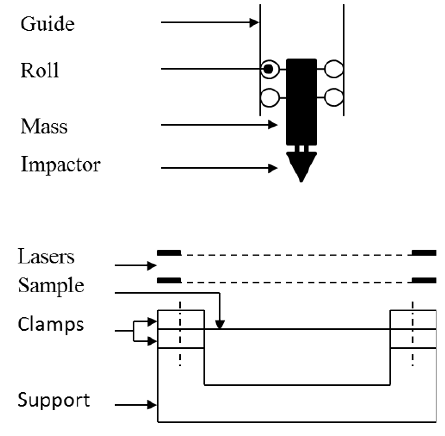
Figure 2. Schematic of the drop test